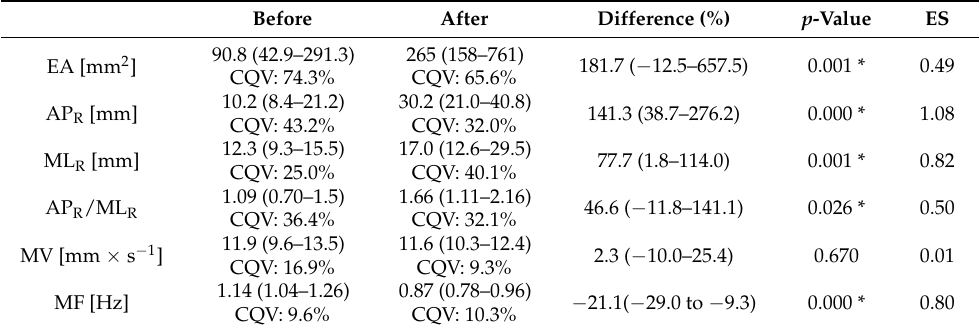
Table 4. Postural control indices before and after the effort (eyes